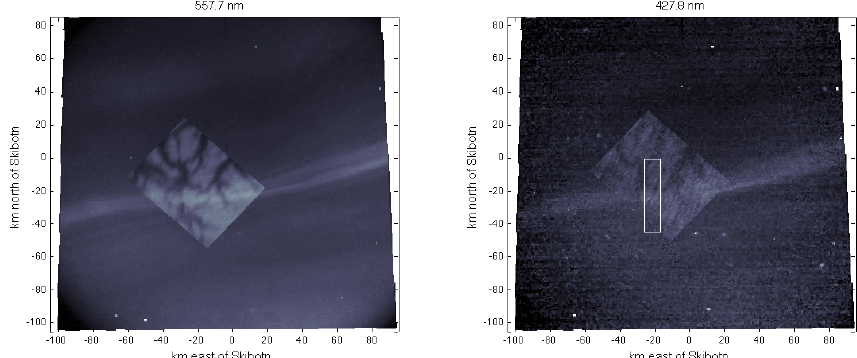
Figure 2. Images of the auroral arc from the ALIS camera in Skibotn taken on 8 November 2008 at 00:34:55 and 00:35:05UT, respectively. On top is the average of 25 Reimei images taken between 00:35:02 and 00:35:06. Both are projected to an altitude of 110km. The white box corresponds to the area where the mean value of the intensity was calculated.